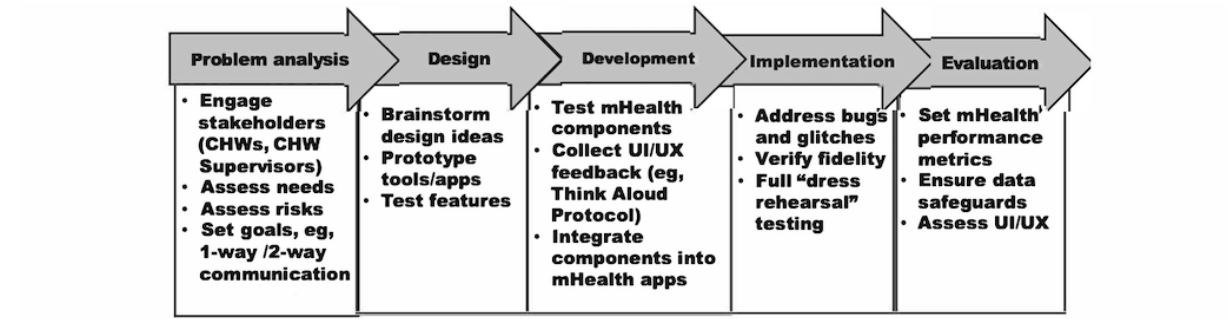
Figure 2. User-centered Design Process for mHealth Tool